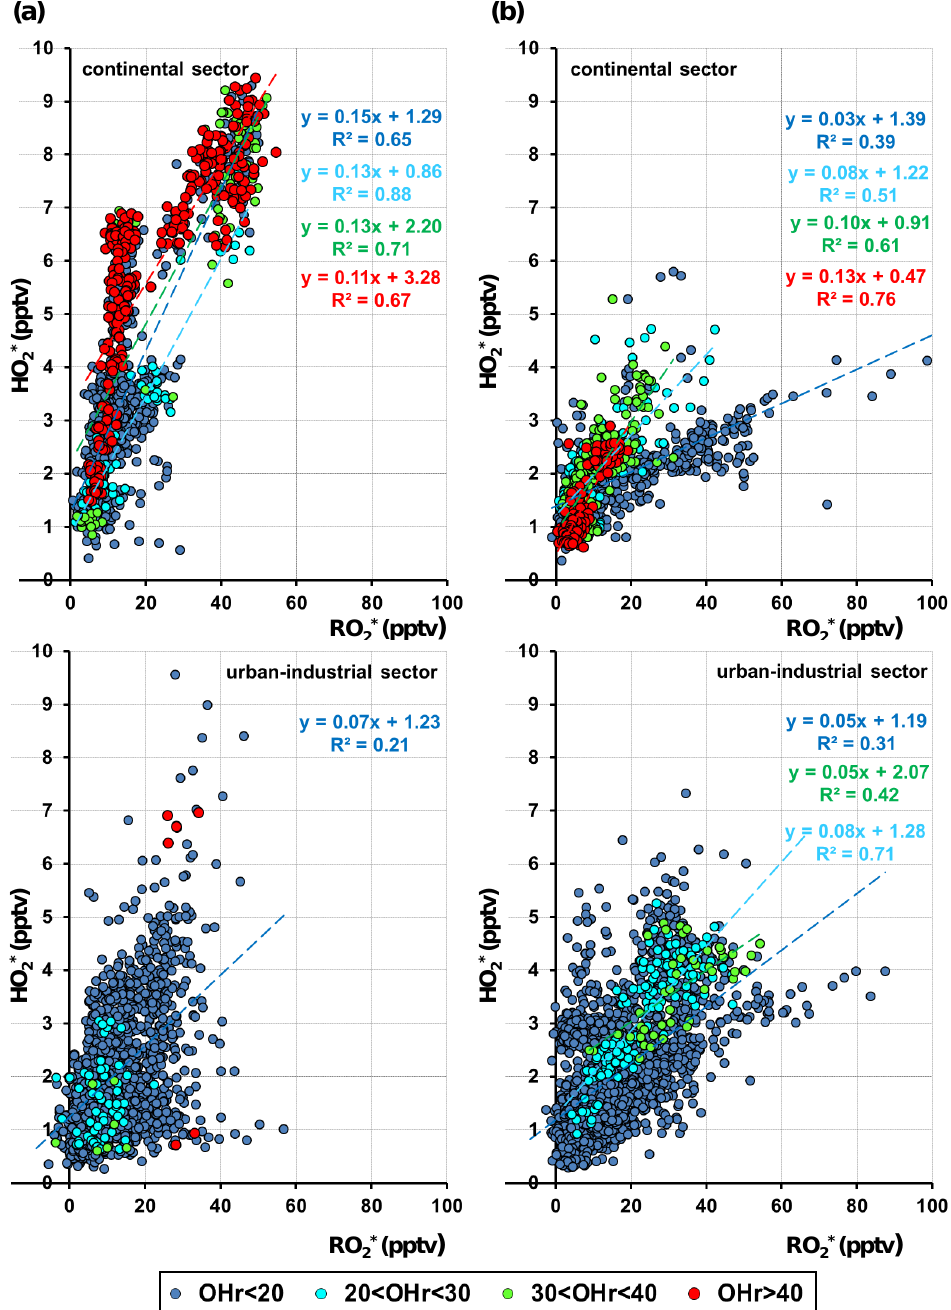
versus RO ∗ for different OH reactivities (OHr in s − 1 ) measured during DOMINO within the urban-industrial and conti- Fig. 14. HO ∗ 2 2 nental sectors. Data for (a) photochemical (06:00–17:00UTC) and (b) non-photochemical (00:00–06:00 and 17:00 to 24:00UTC) radical production are plotted